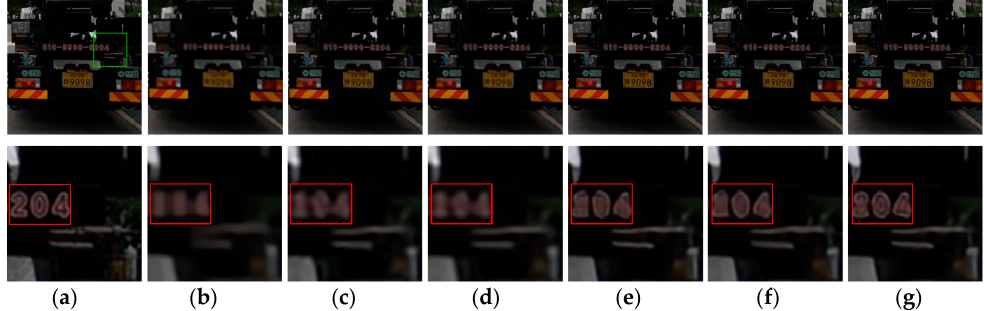
Figure 15. Deblurred results for test image with 17 × 17 Gaussian blur kernel of deviation 2.4. The first row shows the sharp image and deblurred images for the evaluated methods. The second row shows the enlarged views of the region marked with the green box in the original image and the deblurred images.